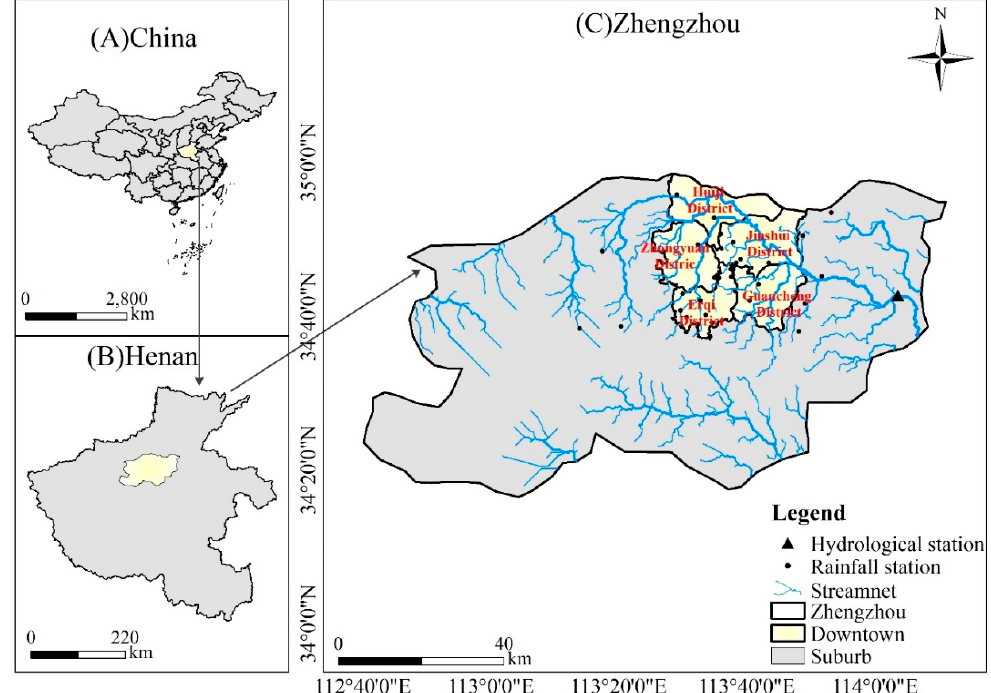
Figure 1. Location map and rainfall-runoff gauge stations of Zhengzhou. ( A ) Inset map showing the location of Henan province in China; ( B ) Location of Zhengzhou in Henan province; ( C ) Location of Zhengzhou and distribution of rainfall-runoff gauge stations.